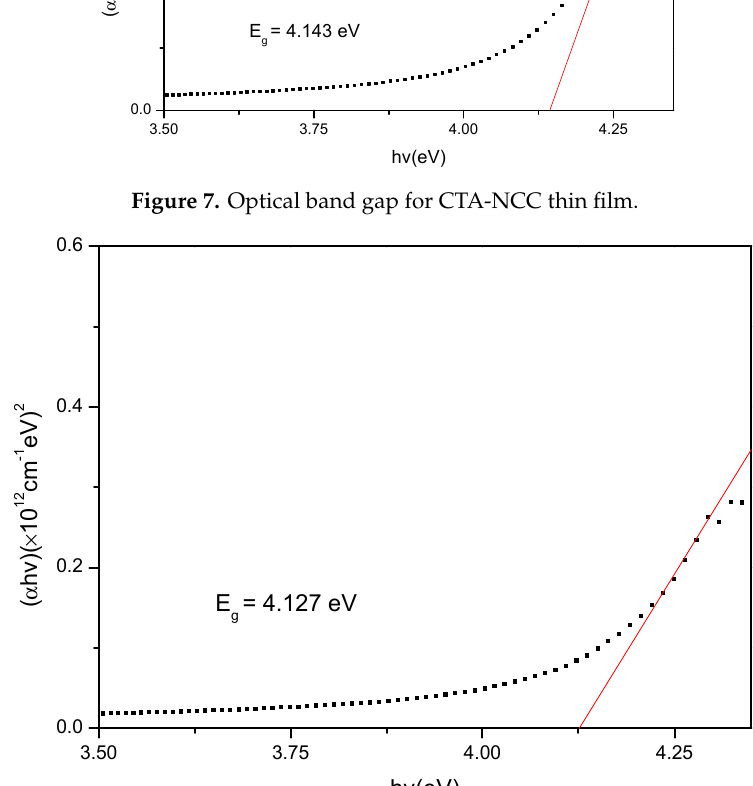
Figure 8. Optical band gap for CTA-NCC/CGQD thin film.